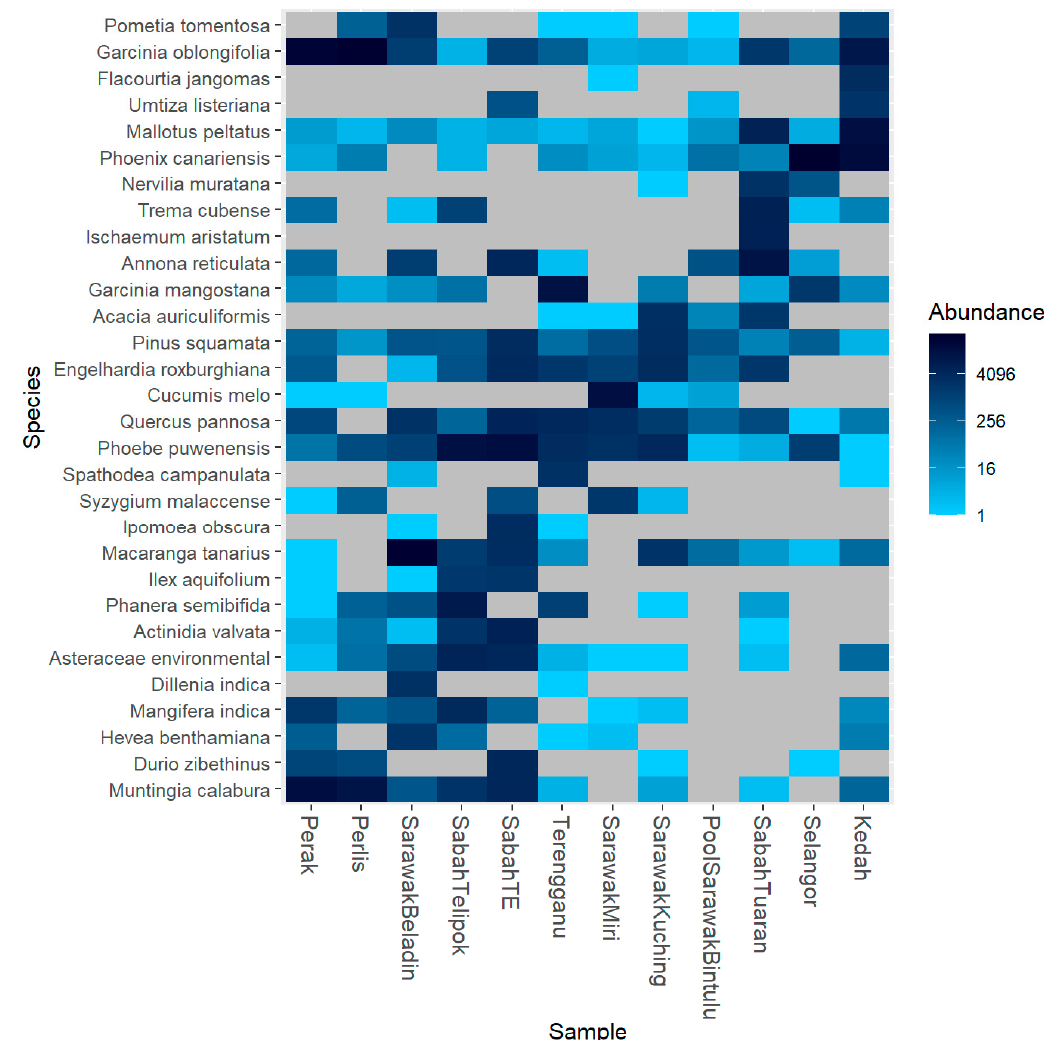
Figure 4. Heatmap at species level. The 30 most abundant genera were used in hierarchical clustering. A darker color indicates a more dominant genus.